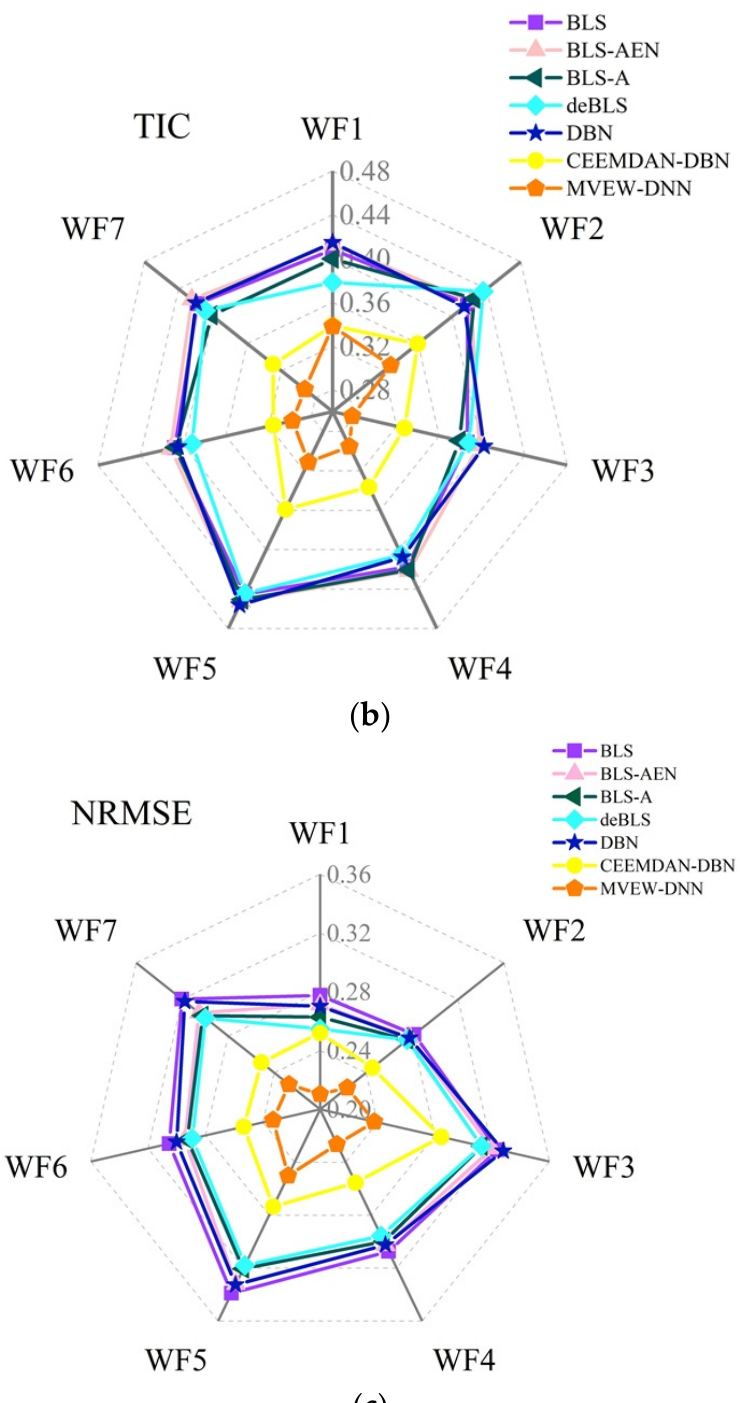
Figure 6. Ablation experiments on NMAE, TIC, and NRMSE evaluation indicators for 7 wind power data sets: ( a ) results of ablation experiments on NMAE evaluation indicators for 7 wind power data sets; ( b ) results of ablation experiments on TIC evaluation indicator for 7 wind power data sets; ( c ) results of ablation experiments on NRMSE evaluation indicator for 7 wind power data sets.